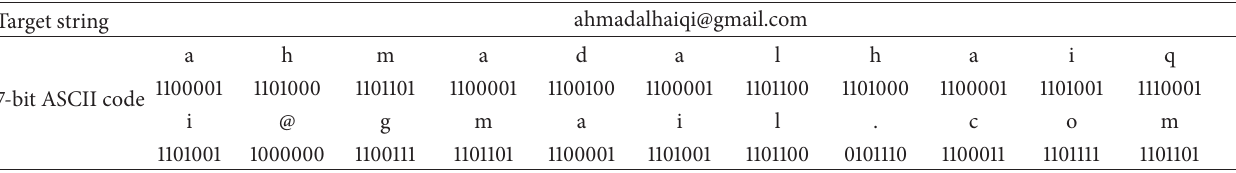
Table 2: Example of encoding from a character string up to the vibration pattern. The bit vibration interval is 200 ms and the initial delay is 0.